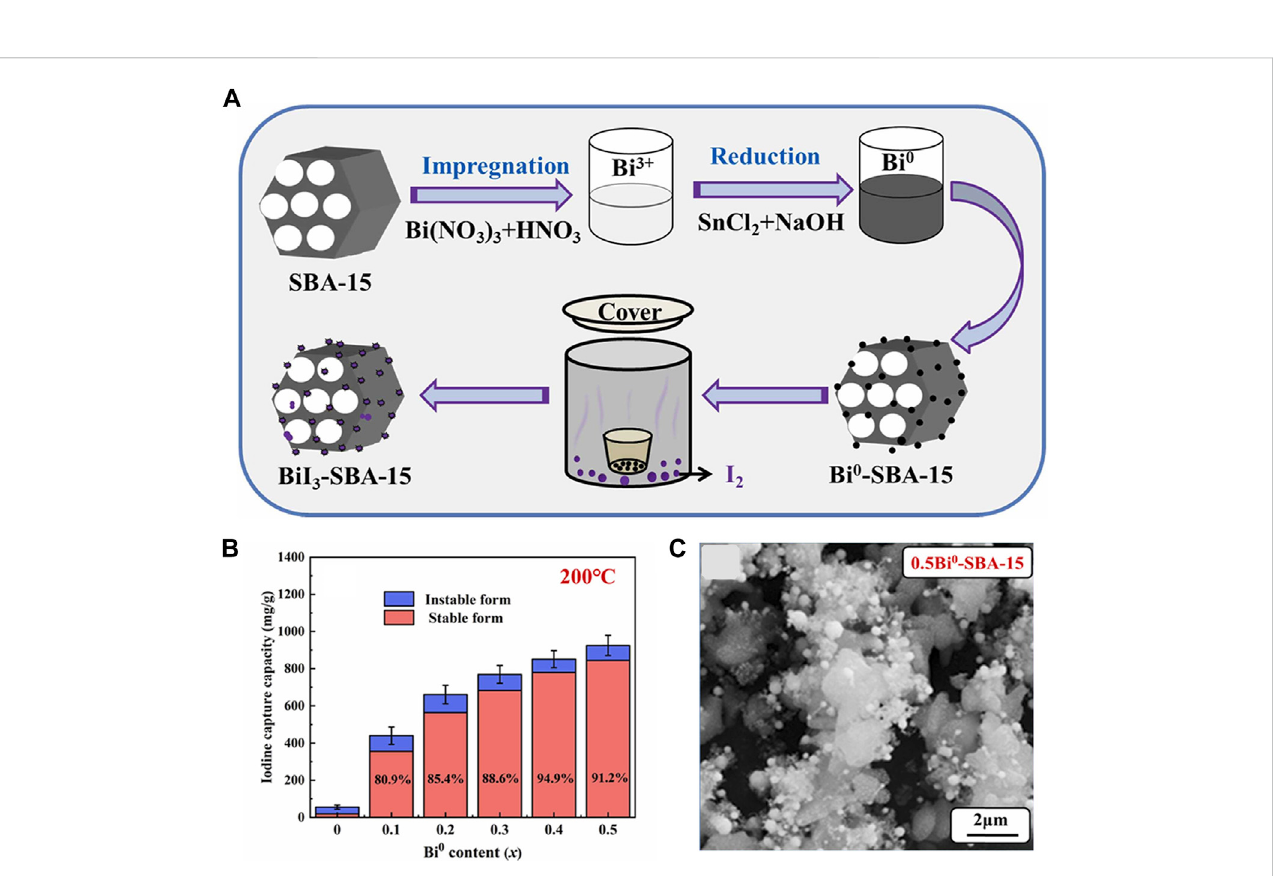
FIGURE 3 (A) Preparation and Iodine Adsorption of Bi 0 -SBA-15; (B) Capture Capacity of Iodine at 200 ° C; (C) SEM image of 0.5Bi 0 -SBA-15 (Xian et al., 2022a).